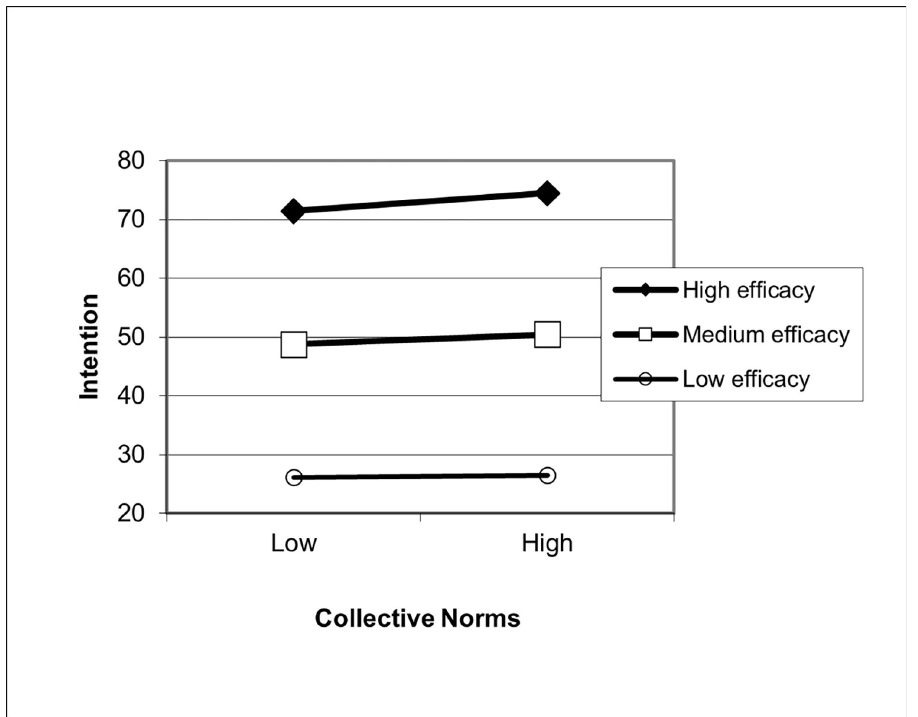
Fig 3. Relationship between collective norms and intentions moderated by efficacy beliefs. The interaction between collective norms and efficacy in predicting intentions is plotted here. Collective norms are plotted on the x-axis; intentions is plotted on the y-axis. The best fitting line for intention regressed onto collective norms is shown by varying levels of efficacy. High efficacy is defined as 1 standard deviation above the mean, medium efficacy is defined as the mean, and low self-efficacy is defined as one standard deviation below the